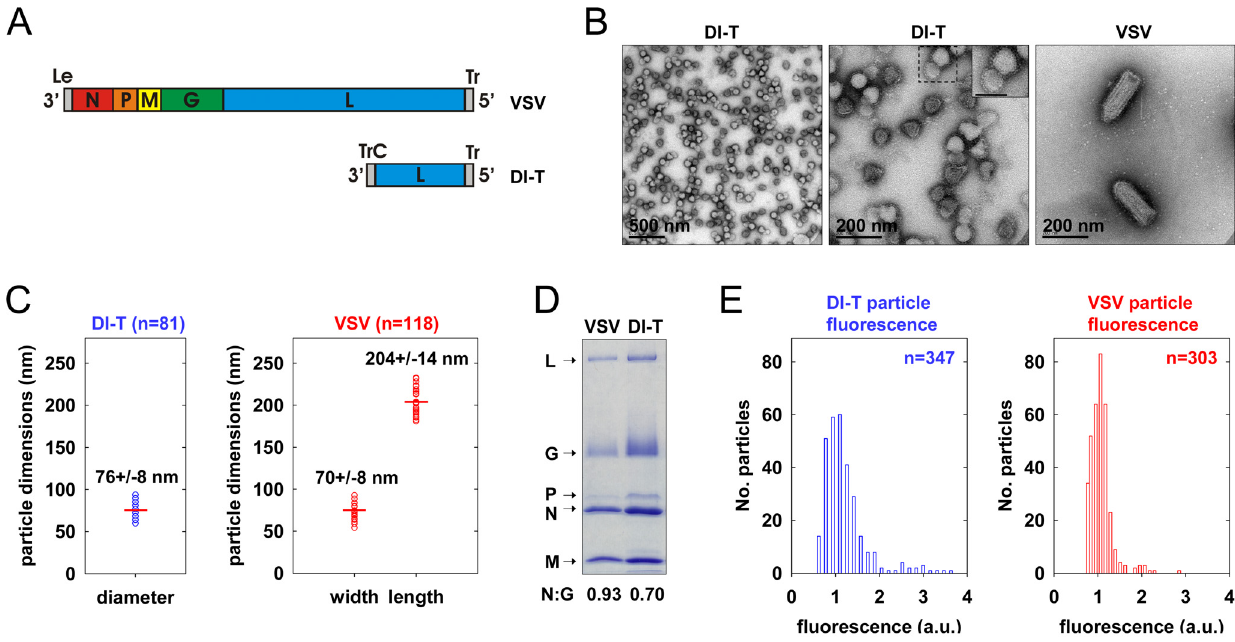
Figure 1. Biological properties of DI-T particles. (A) Structure of VSV and DI-T genomic RNAs. The single-stranded negative-sense RNA genomes are shown in a 3 9 -5 9 orientation. The five viral genes are colored as follows: red nucleocapsid (N) protein gene; orange, phosphoprotein (P) gene; yellow, matrix (M) protein gene; green, glycoprotein (G) gene; blue, large (L) polymerase protein gene. The noncoding genomic terminal leader (Le) and trailer (Tr) regions, which serve as promoters for RNA synthesis and genomic RNA encapsidation, are shown in gray. The DI-T genome comprises 2,208 nts. The 5 9 terminal 2,163 nts derive from the 5 9 terminus of the parental VSV genome (11,161 nts), and the 3 9 terminus contains a 45 nt inverted complement of the wild-type Tr (TrC). (B) Electron micrographs of purified VSV and DI-T particles negatively stained with PTA. Middle panel, inset shows an expanded view of virions from the boxed region to facilitate visualization of the viral glycoprotein spikes. Inset scale bar, 100 nm. (C) Virion geometry. The dimensions of individual DI-T (blue) and VSV (red) particles measured from electron micrographs of negatively stained particles. Each open circle represents the measurement for a single particle. Horizontal red lines denote the mean value of each population, and the numerical means ( + / 2 SD) are provided above each plot. (D) Protein composition of purified VSV and DI-T particles. Viral proteins (L, G, P, N, and M) were separated by SDS-PAGE and visualized with Coomassie blue staining. The ratio of N protein to G protein was quantified using ImageJ and is displayed below the gel as a comparative measure of average virion surface glycoprotein density in each particle population. (E) Fluorescence intensity of virus particles labeled with Alexa Fluor dye molecules. Purified DI-T or VSV particles were labeled with Alexa Fluor 647 or 568 and imaged on separate glass coverslips using a spinning disk confocal microscope. The fluorescence intensity of individual spots in a single field of view was quantified, and the distribution of intensity values (in arbitrary units, a.u.) for DI-T (blue) and VSV (red) particles is shown.